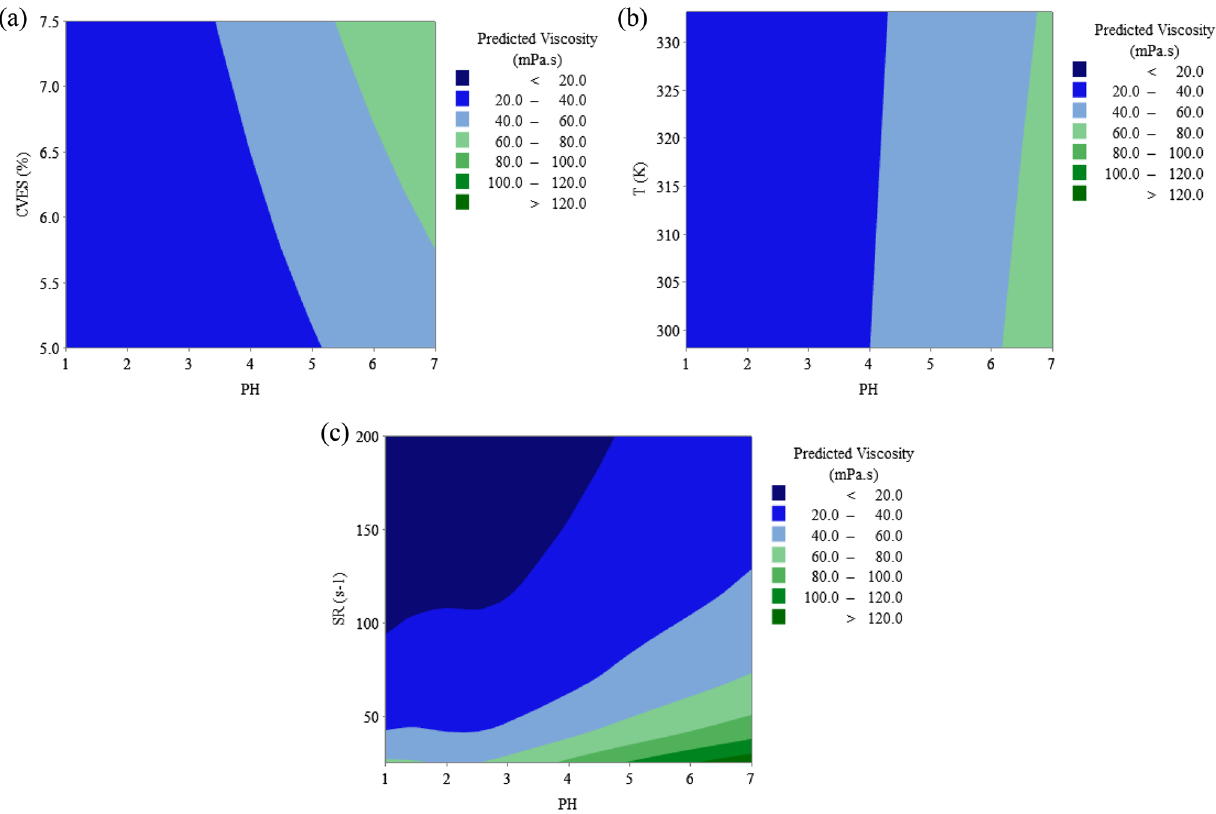
), pH, shear rate (SR), and tem- VES